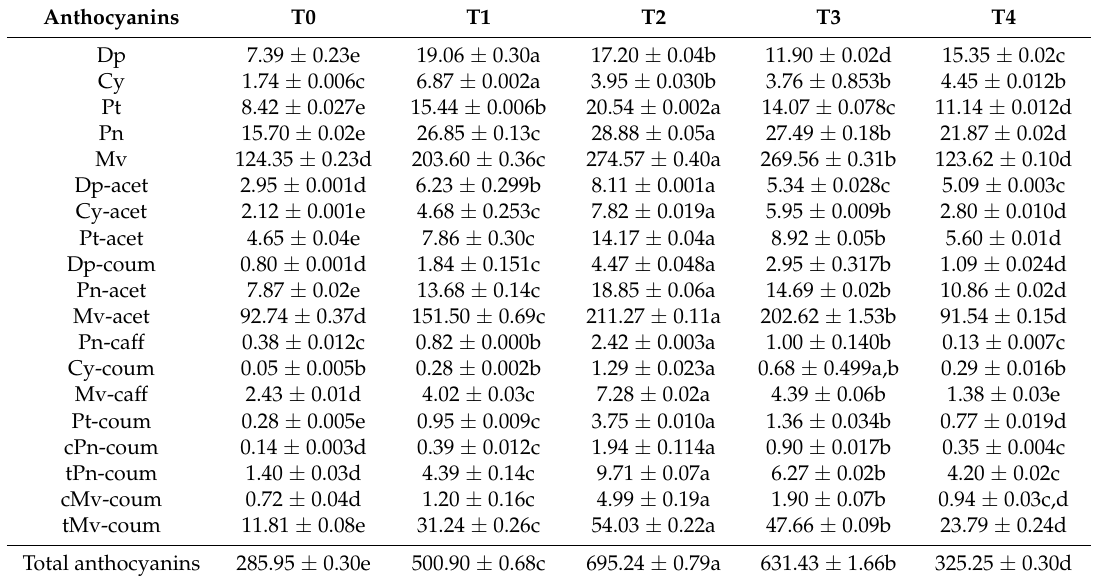
Table 3. Effects of iron supply on individual anthocyanins ( µ g/g berry) in grape berries. Different lowercase letters indicate significant differences between treatments as calculated by Tukey’s HSD test ( p <